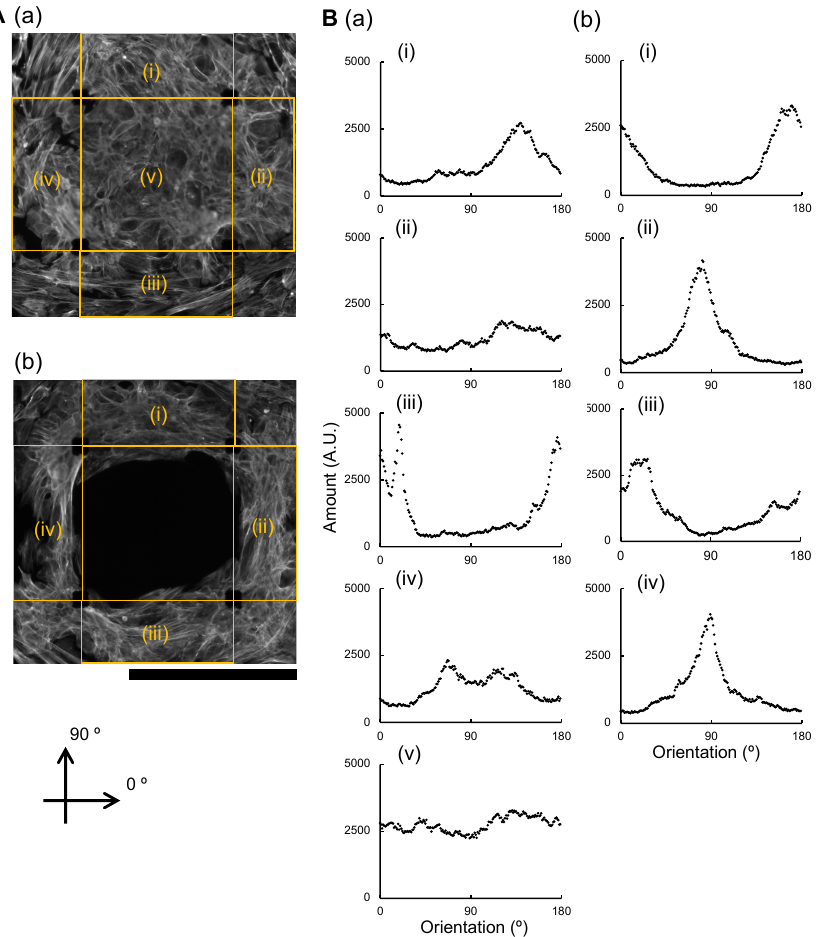
Figure 7. Cell orientation analysis of cardiomyocytes in the large square sheet and closed-loop sheet microchambers. ( A ): Fluorescent micrographs of hES cardiomyocytes in the large square agarose microchamber ( a ) and closed-loop agarose microchamber ( b ) on an MEA chip seven days after cultivation started. Rhodamine Phalloidin stained actin filaments in cardiomyocytes. Bar, 0.5mm. ( B ): Cell orientation distribution in large square sheet ( a ) and square closed-loop-shaped sheet ( b ). Acquired images were divided into five ( a ) and four ( b ) areas, and their cell orientation distribution estimated by actin filament orientations in each cell were analyzed. ( i – iv ) represent the four sides of the large square sheet, and closed-loop-shaped sheet, ( v ) is the inner central area of the large square